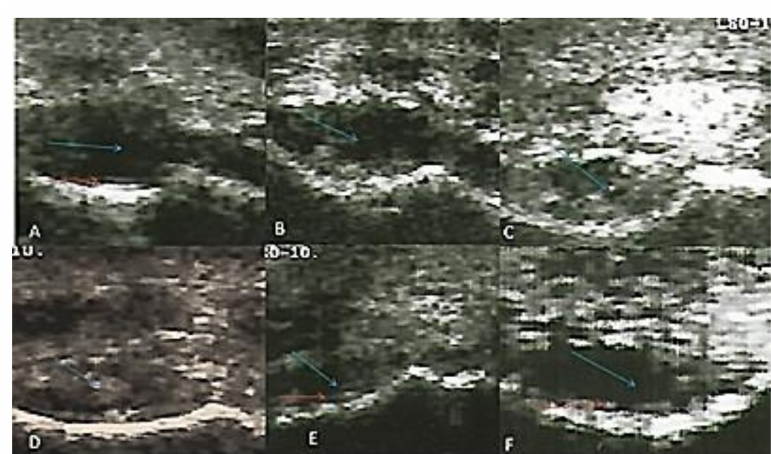
Figure 2. Transverse flexed scan of the radio-carpal joint at ( A ) day 0, ( B ) first month, ( C ) second month, ( D ) third month, ( E ) fifth month, ( F ) seventh month after induction. Synovial sac showed hypo-echoic mass within the synovial fluid (blue arrows). The articular cartilage appeared normal at day 0 and showed a defect in continuity seven months after induction (red